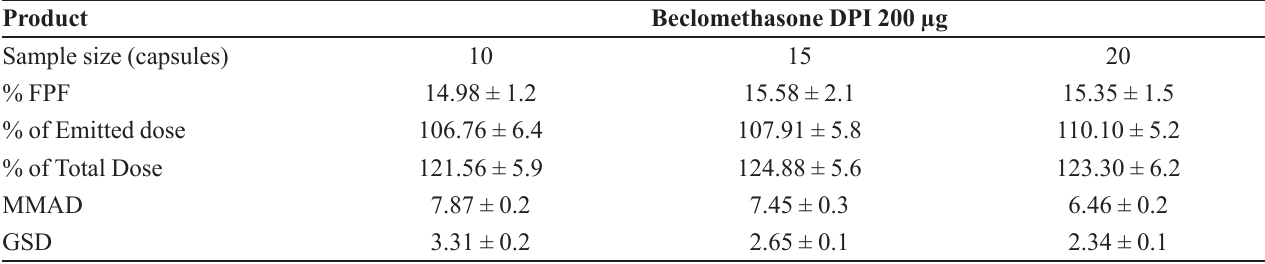
TABLE VI - Effect of sample size on cascade impactor testing of beclometasone DPI Product